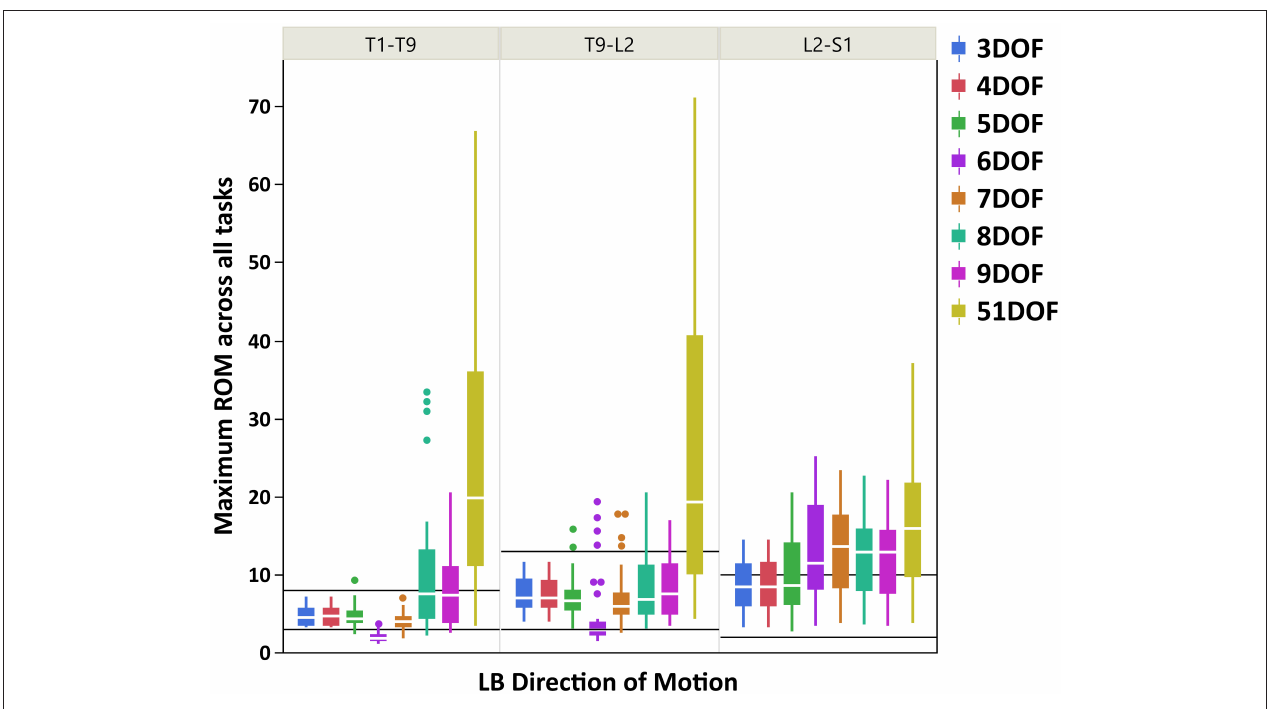
FIGURE 4 | Boxplot of maximum ROM of 17 intervertebral joint angles, grouped in three spine regions [i.e., “T1-T9”: T1/T2 to T8/T9; “T9-L2”: T9/T10 to L1/L2; “L2-S1”: L2/L3 to L5/S1], for all kinematic constraints [3–9DOF and no constraint (51DOF)] in LB direction of motion. The black lines horizontally overlaid on each panel plot are minimum and maximum ROM of intervertebral joints for the corresponding spine regions in LB direction of motion, reported by White and Panjabi (1978). ROM, range of motion; DOF, degrees of freedom; LB, lateral